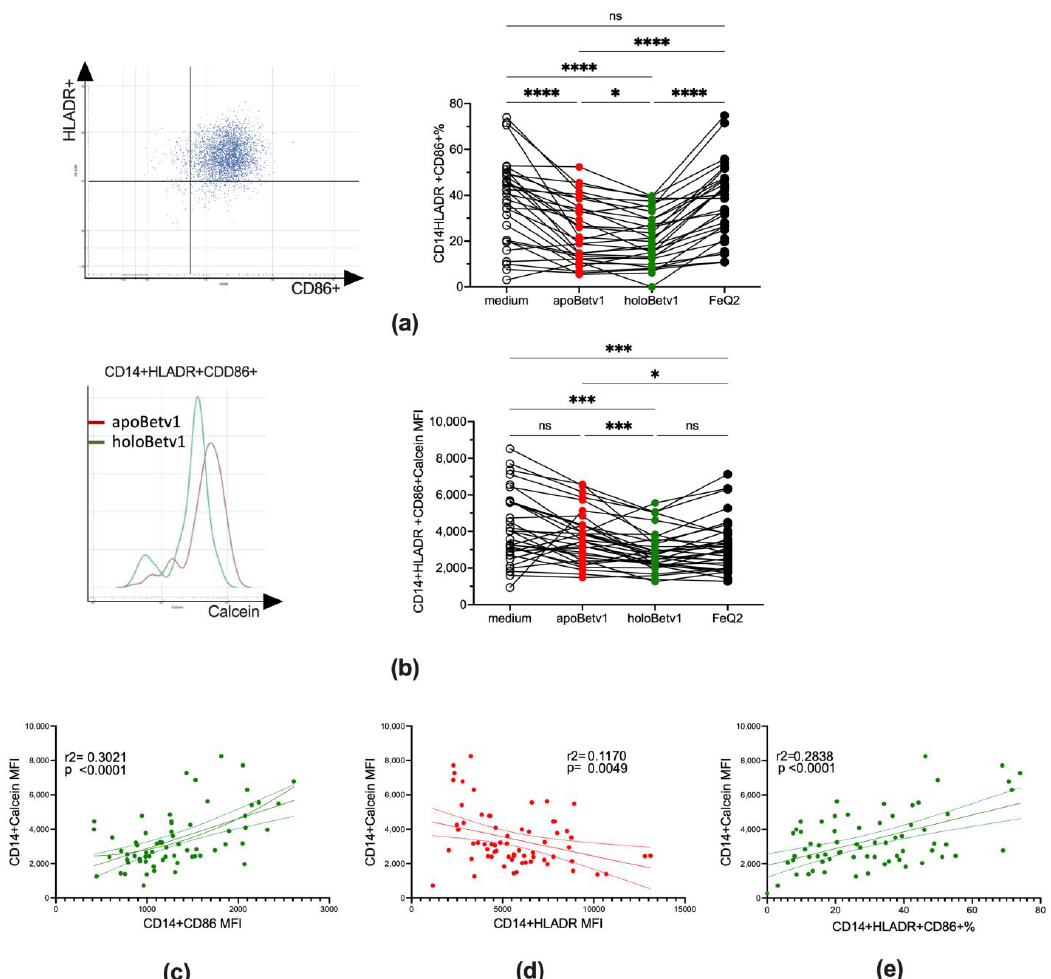
Figure 4. HoloBet v 1 decreased antigen presentation is associated with an increase of labile iron in monocytic cells. Flowcytometric analyses of PBMCs ( n = 34) stimulated with medium, iron-quercetin (FeQ2), apoBet v 1 alone or in combination thereof (holoBet v 1). ( a ): gating strategy and relative numbers of CD14+HLADR+CD86+ in the monocytic gate and ( b ): the respected MFI of the calcein signal. Linear regression analysis of the Calcein signal of CD14+ cells ( c ): versus CD86 expression and ( d ): HLADR expression as well as ( e ): calcein-signal of CD14+ with the relative numbers of CD14+HLADR+CD86+ cells. Data were analysed in ( a , b ) by mixed-effect analysis. All data were Geisser-Greenhouse corrected and followed by Tukey’s multiple comparisons test. ( c – e ). Simple linear regression models of data with 95% confidence bands are depicted. * p < 0.05; *** p < 0.001; **** p < 0.0001; ns = not